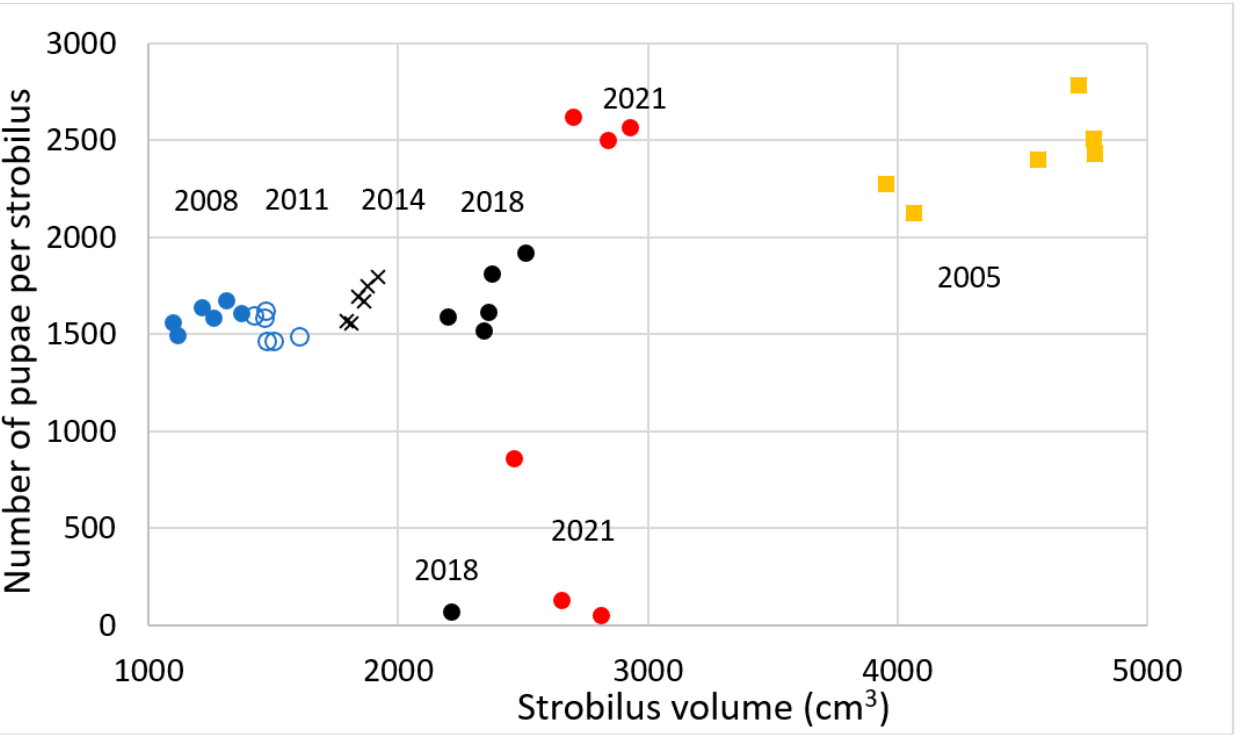
Figure 4. The number of pupae per strobilus versus strobilus volume, with 2005 being the pre-invasion year, and then the post-invasion years starting in 2008 until 2021. Orange squares = 2005 data; blue-filled circles = 2008 data; blue open circles = 2011 data; black ‘x’ = 2014 data; black circles = 2018 data; and red circles = 2021 data.